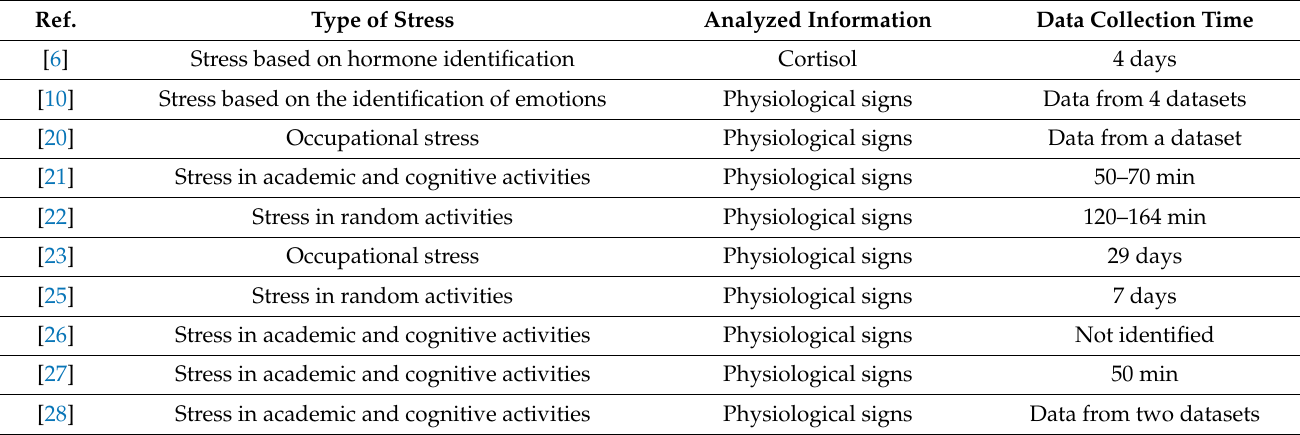
Table 2. Summary of the studies selected in the systematic review. Ref.